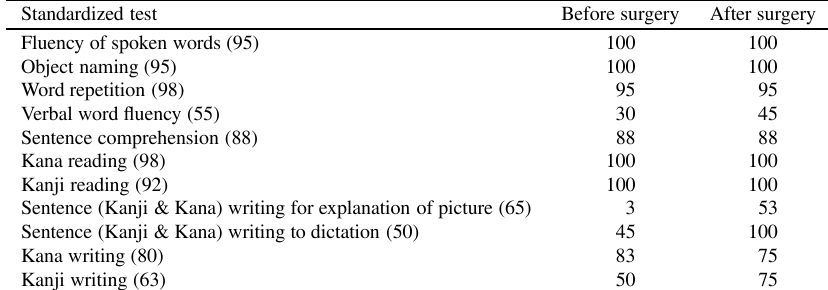
Table 1 Summary of test results for language function before and after